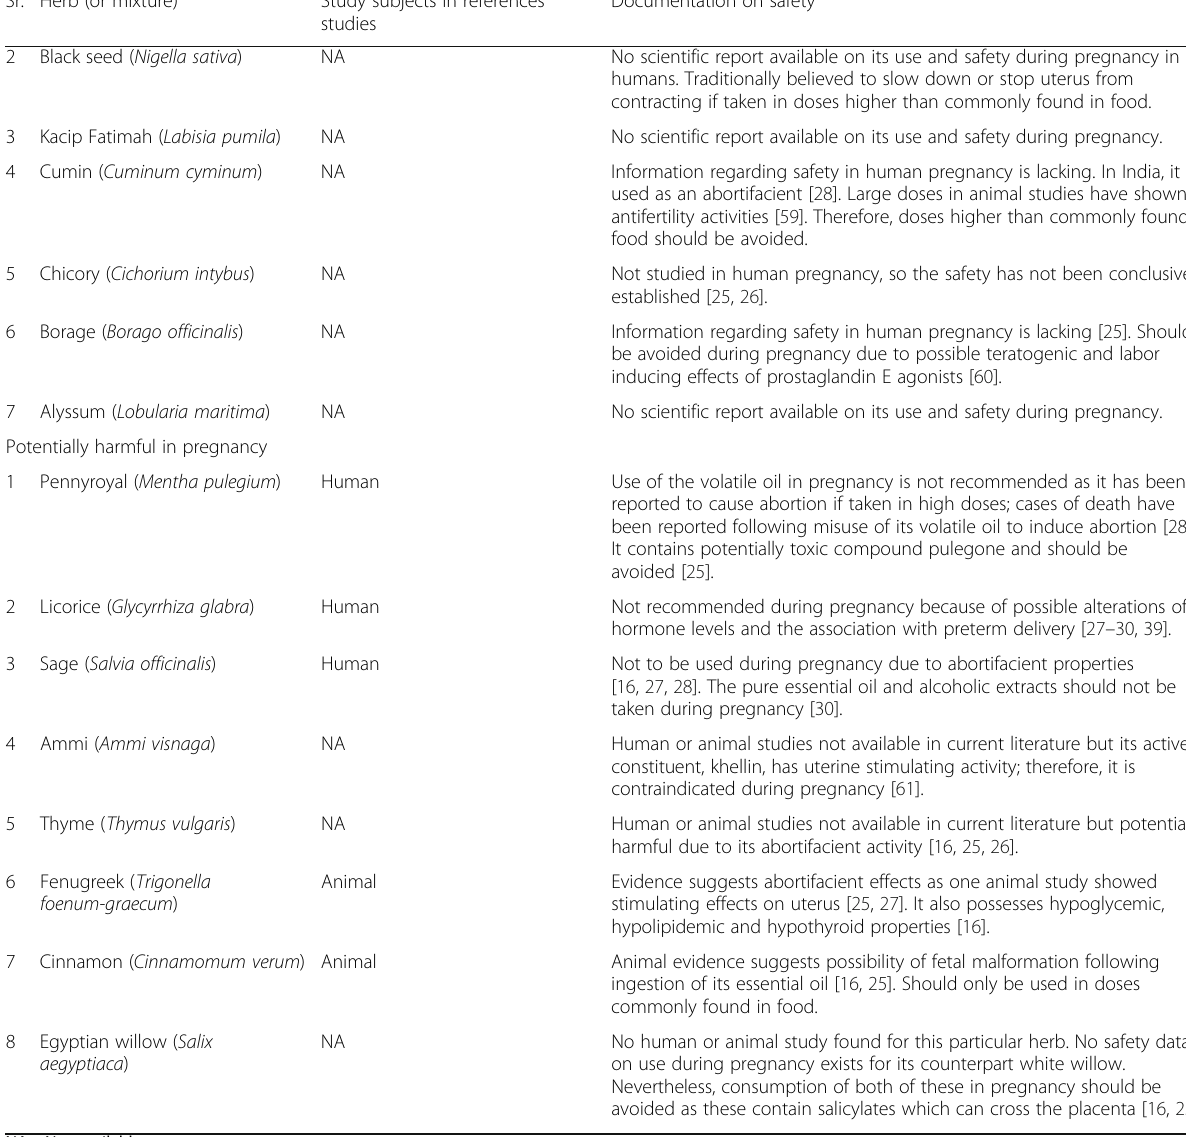
Table 5 Documentation on safety of most frequently used herbs during pregnancy (Continued) Sr. Herb (or